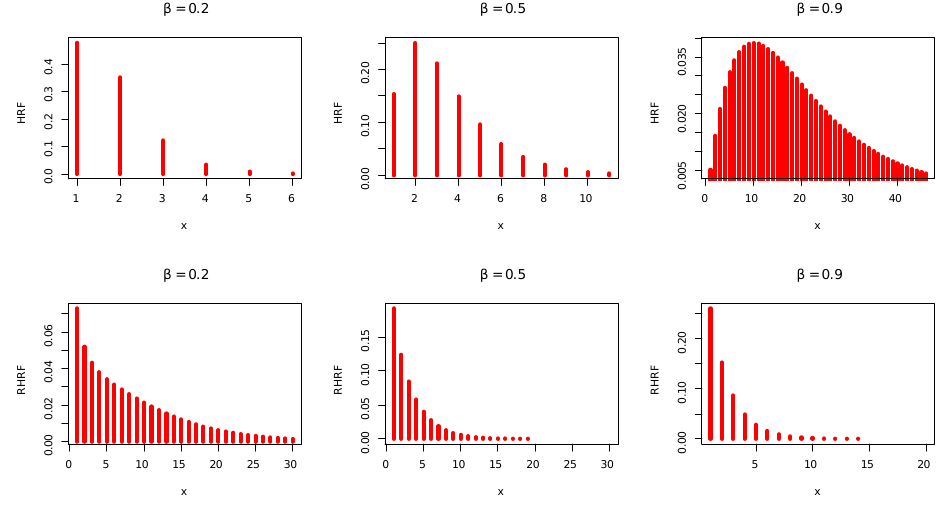
Figure 2. HRF and RHRF visualization plots for the DMEx Figure 2 . HRF and RHRF visualization plots for the DMEx model. Both HRF and its reversed function can be e⁄ectively used to model decreasing or unimodal failure modes.